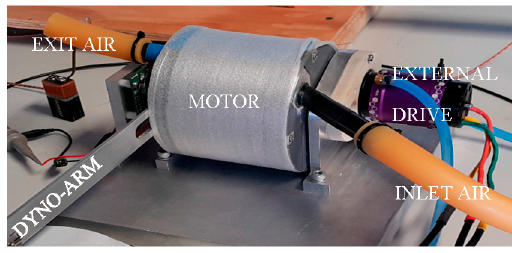
Figure 1. Experimental apparatus.